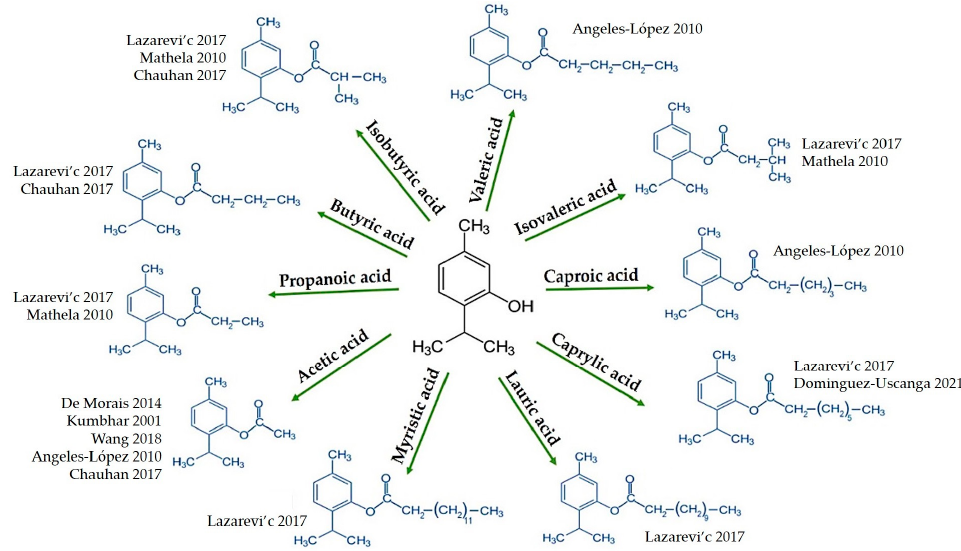
Figure 1. Main esters with biological activity obtained by esterification of thymol and linear and branched carboxylic acids [19,28,36–39,44,48].